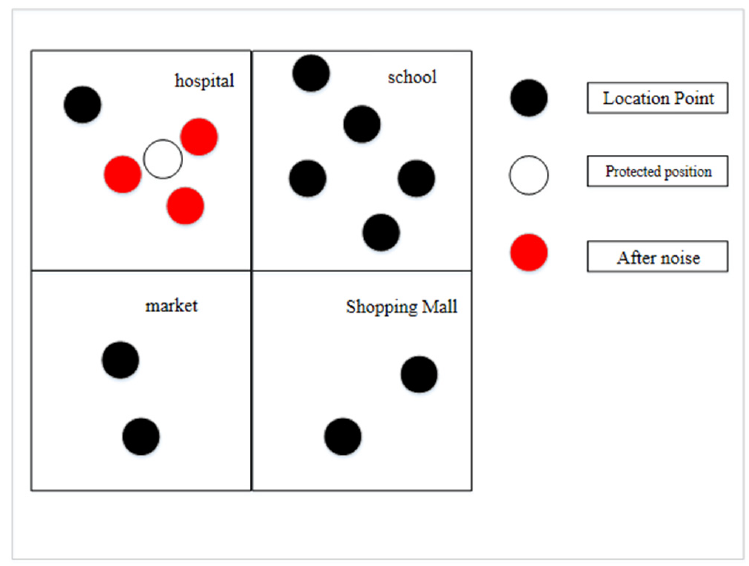
Figure 3. Location semantic attack model.